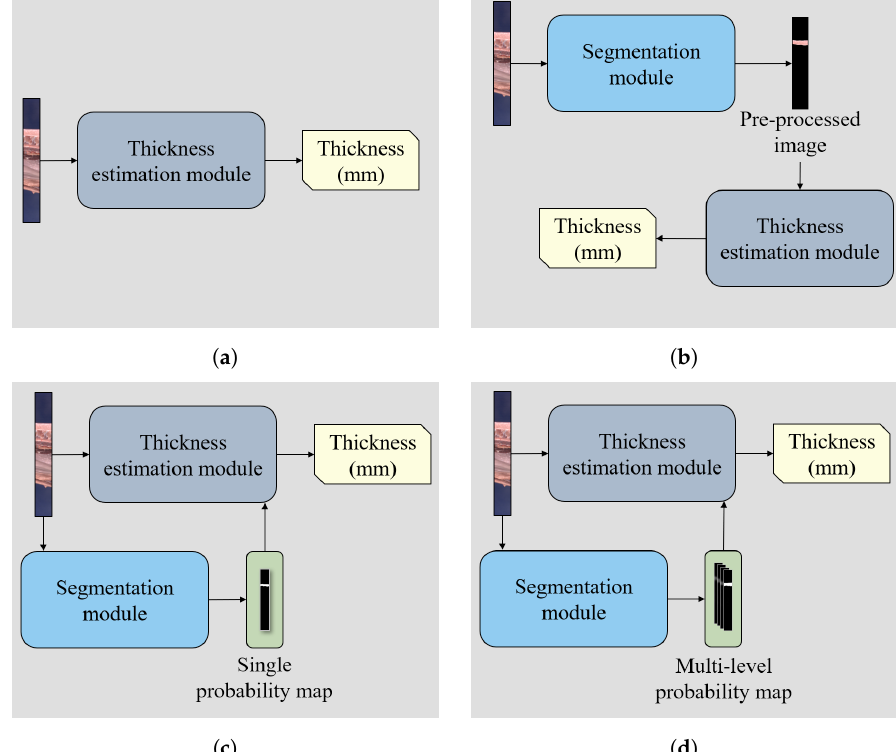
Figure 4. Four different scenarios for the ablation study. ( a ) S1: BTENet without the segmentation module (only thickness estimation module); ( b ) S2: Thickness estimation module with pre-processed input images; ( c ) S3: BTENet with a single probability map; and ( d ) S4 (proposed model): BTENet with multi-level probability maps.